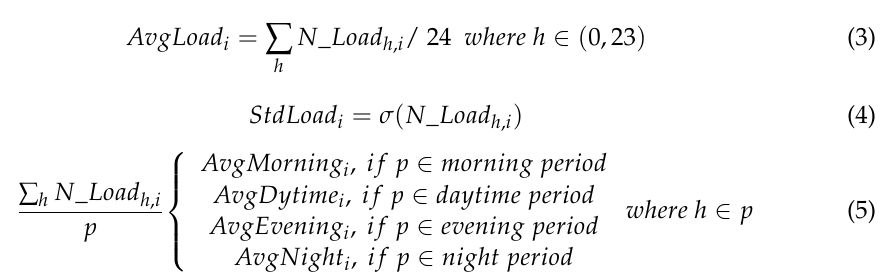
Figure 1. Hourly sum of normalized load of all residential customers.